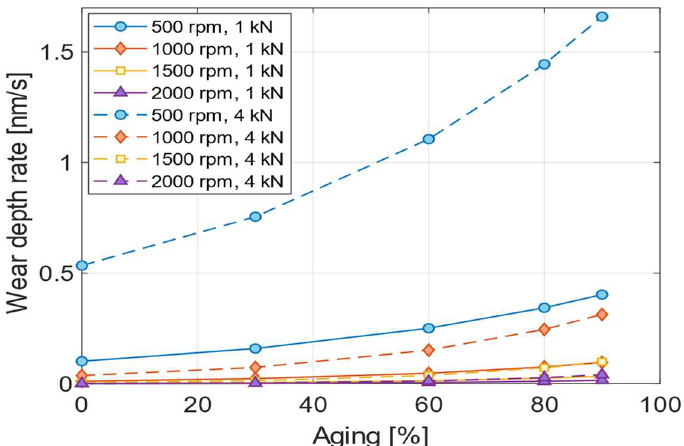
Figure 7. Wear rate versus aging level for different speeds and loads for a ball screw with 5 mm lead and 16 mm nominal diameter (© 2022 IEEE. Reprinted, with permission, from [21]).